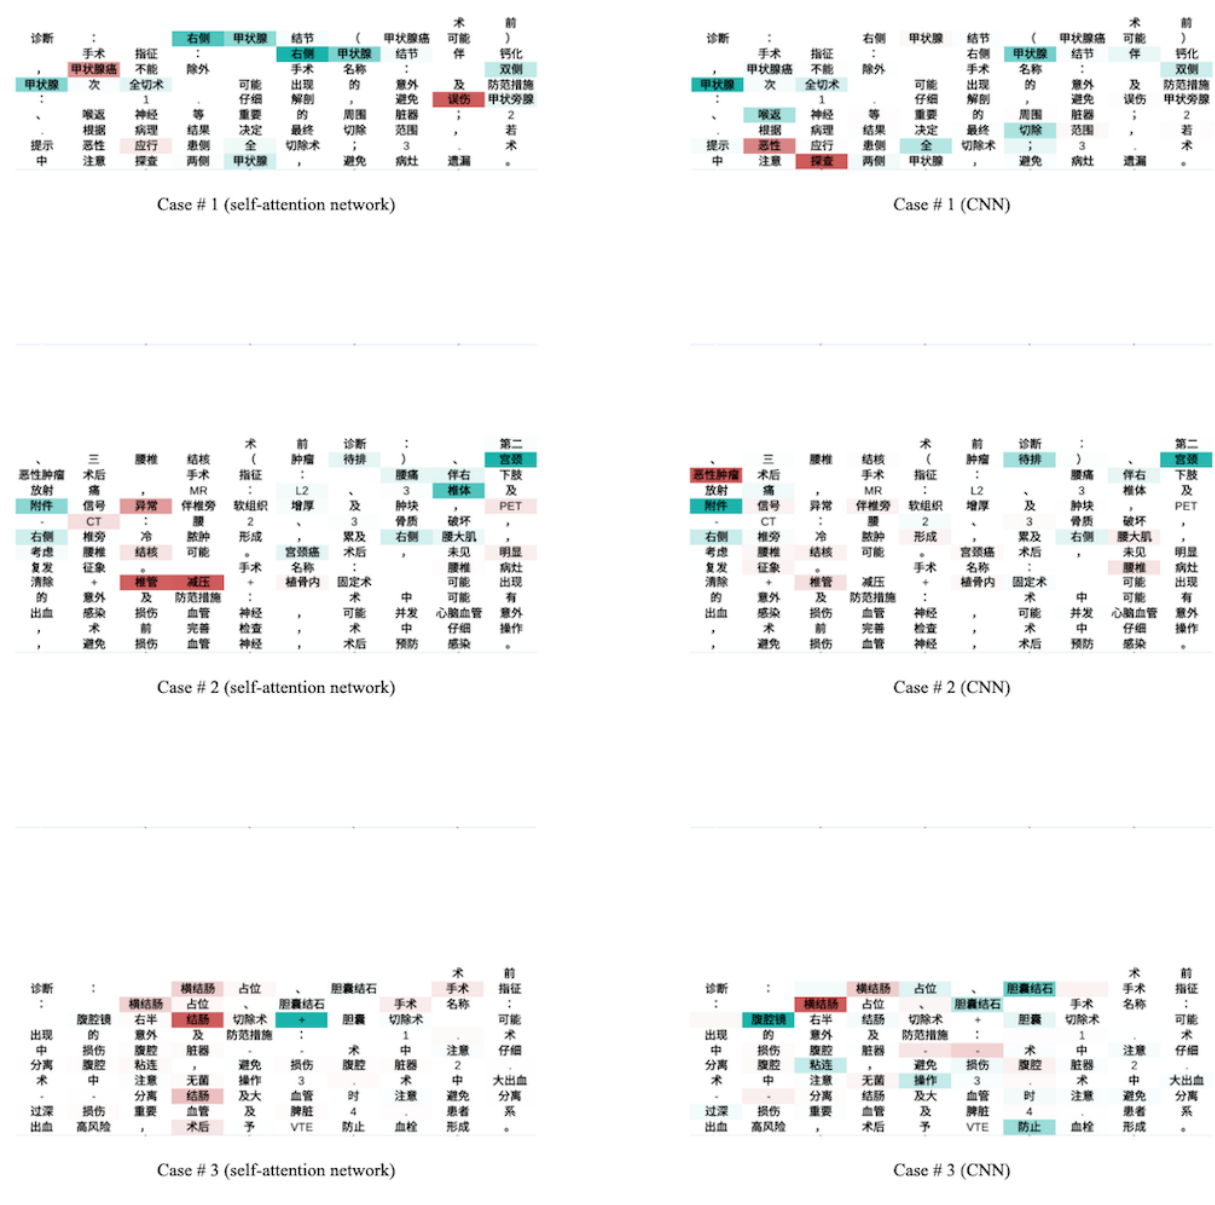
Figure 5. The heatmaps of the word contributions on three preoperative note cases. CNN: convolutional neural